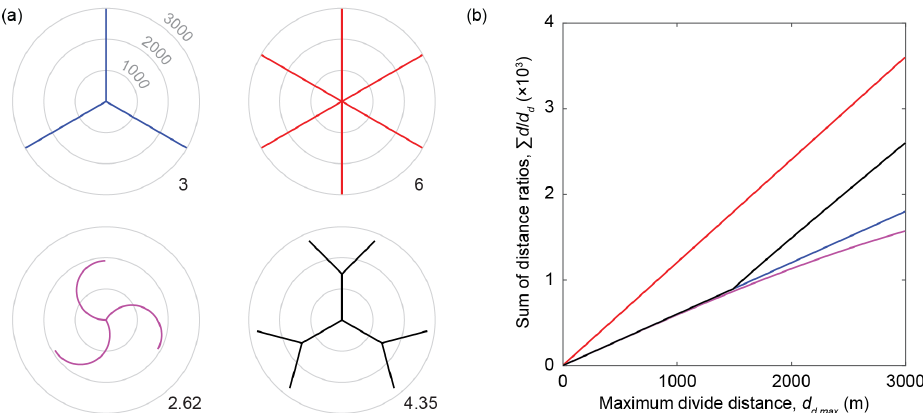
Figure 3. Illustration of the junction connectivity ( C J ) of different drainage divide junctions. (a) Map view of four hypothetical divide junctions. Gray circles indicate Euclidean distance from the junction. Numbers to the southeast in each map give the C J value based on a d d , max of 3000m. (b) Sum of distance ratios ( (cid:80) d/d d ; cf. Eq. 3) as a function of the maximum divide distance for each case in panel (a)